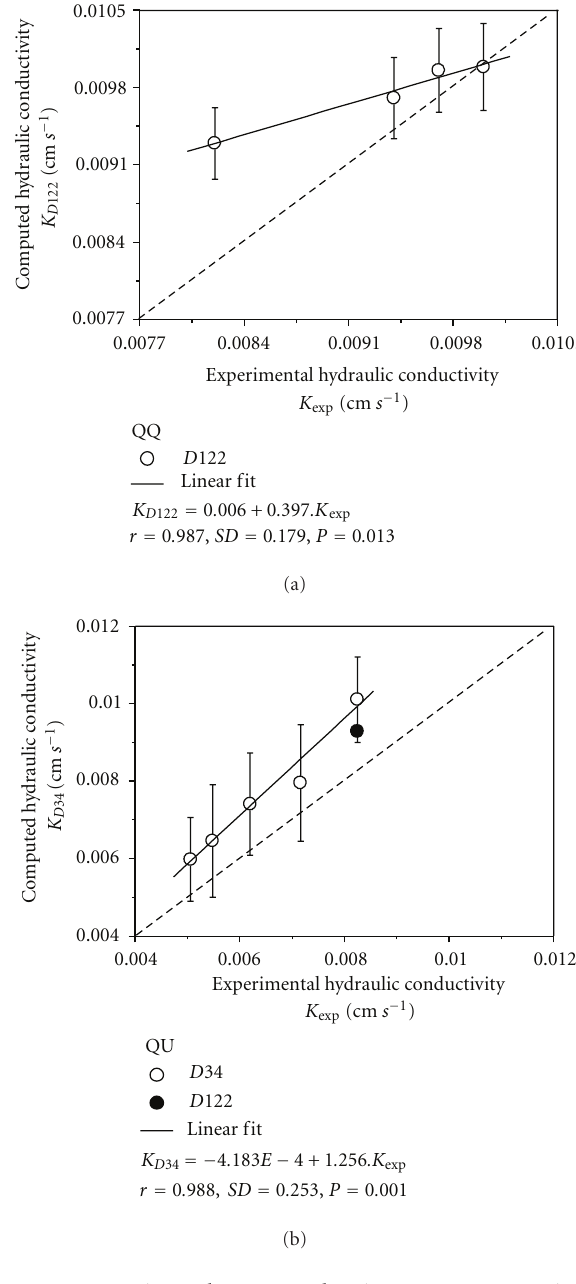
Figure 5: Experimental K measured against LBM computer simu- lated K for: (a) QQ arrangement and (b) QU